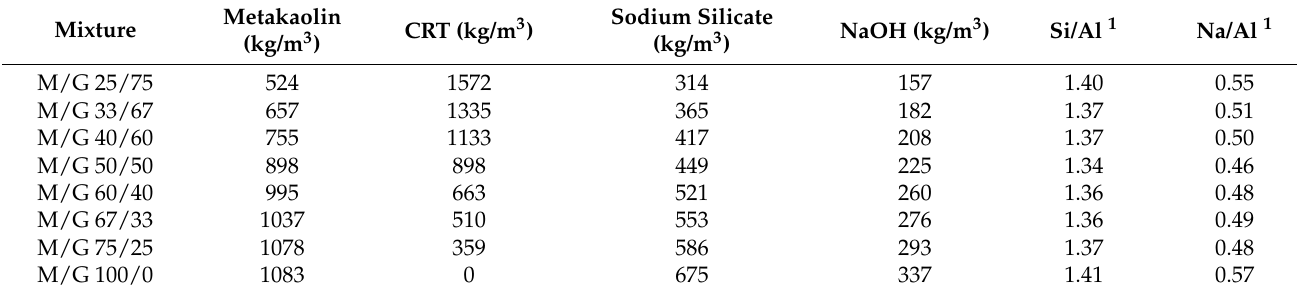
Table 2. Composition of geopolimeric